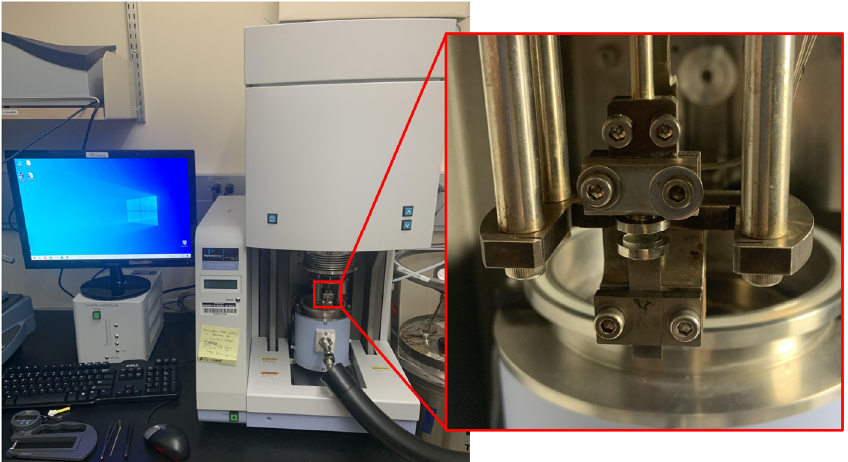
Figure 5. Dynamic mechanical analyzer ( left ) with magnified testing region of PVC gel sample ( right ) to determine stress–strain relationship under compressive loading applications.